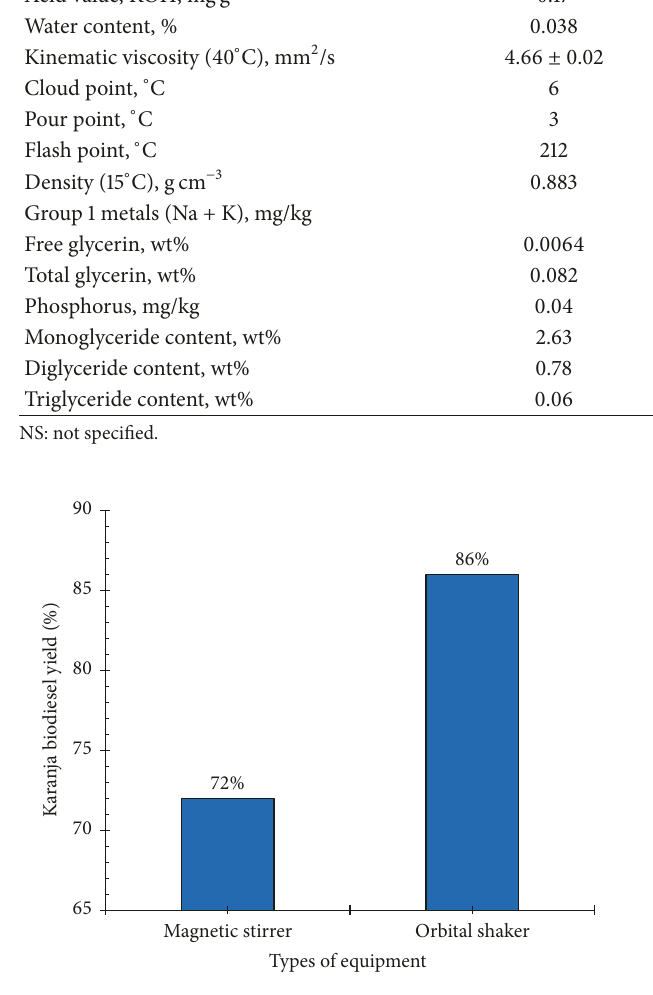
Figure 7: Biodiesel conversion by changing type of